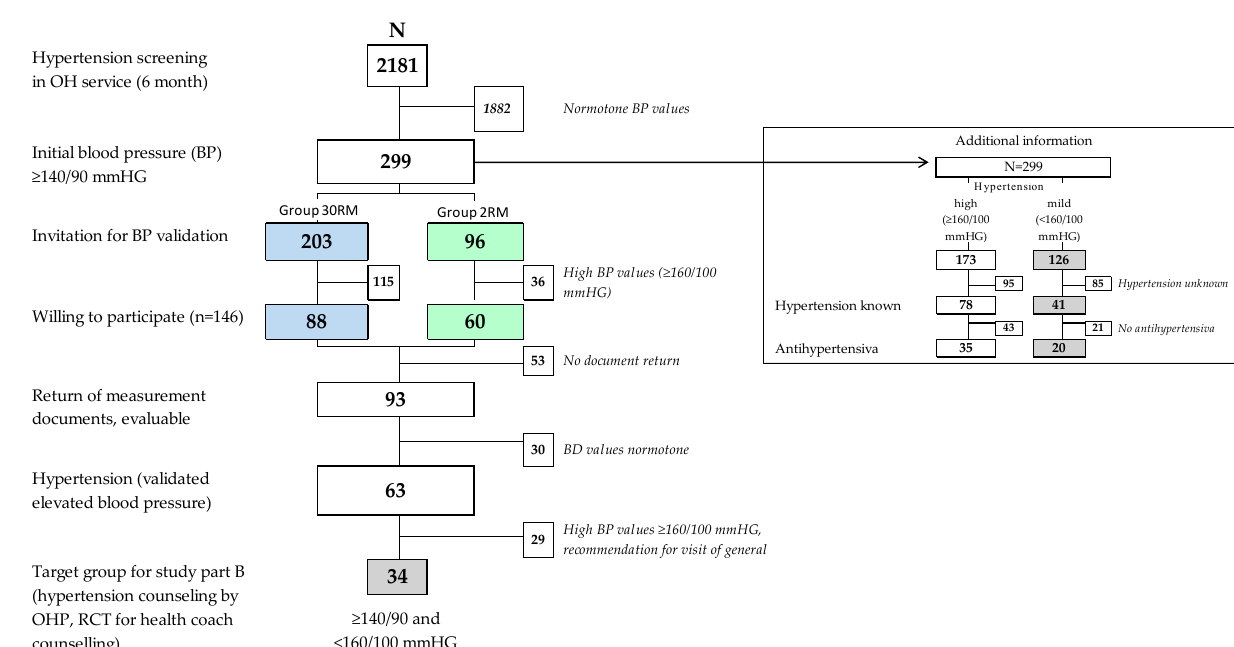
Figure 2. Participants in Study Part A (screening and hypertension validation).Grey shadowed values = employees with slightly elevated blood pressure values ( ≥ 140/90 and <160/100 mmHG). Abbreviations: 30 RM = group with 30 repeated self-measurements; 2 RM = group with 2 repeated measurements in the occupational health service; OHP = occupational health physician; OHS = occupational health service.